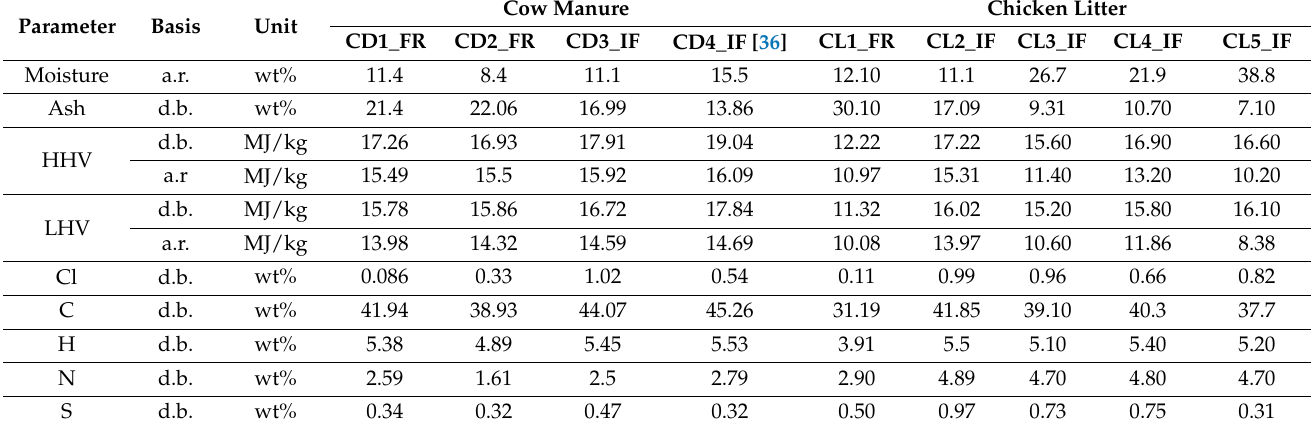
Table 1. Proximate and elemental (ultimate) analysis of feedstock samples (a.r.—as received, d.b.—dry basis).